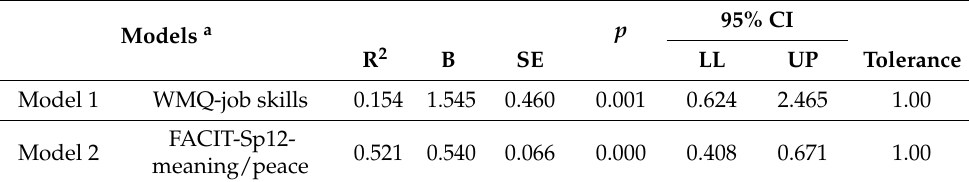
Table 4. Predictive models of psychological